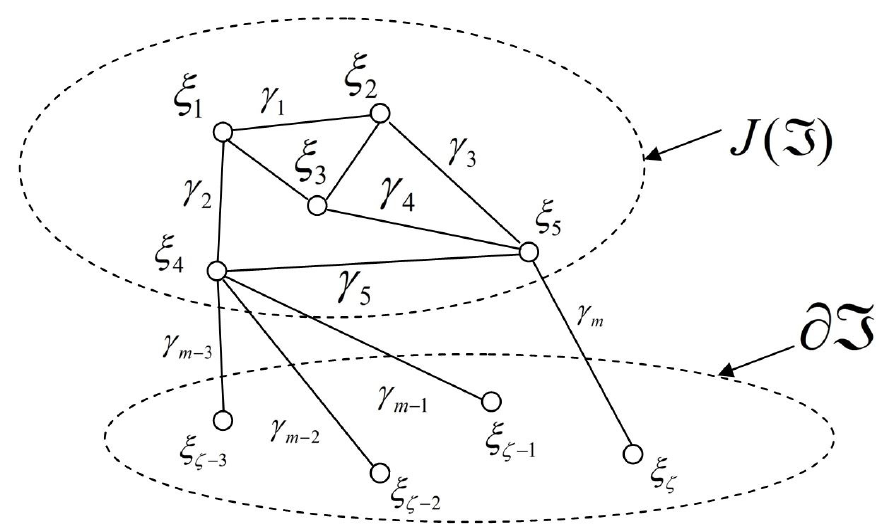
Figure 4. Graph Figure 4. Graph (cid:61) .